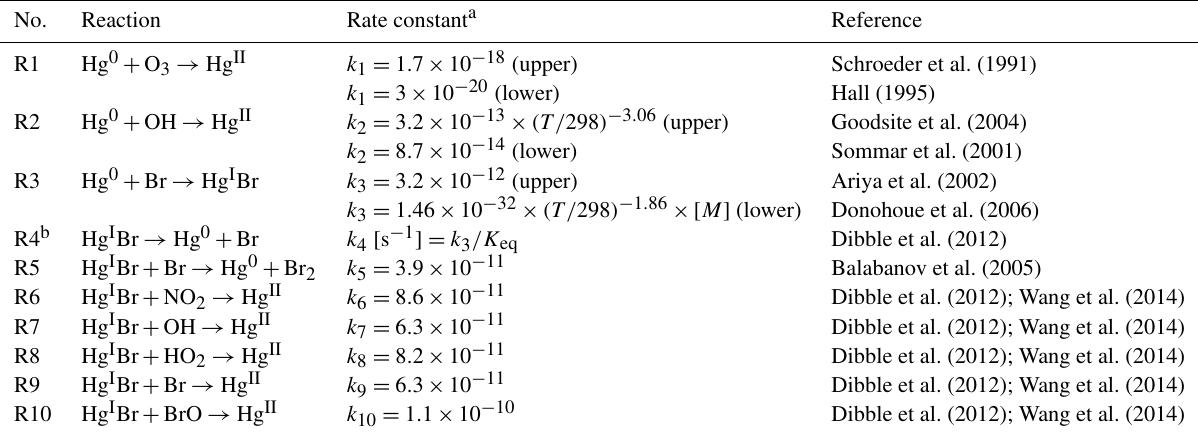
Table 2. Gas-phase mercury reactions used in the mercury model. No. Reaction Rate constant